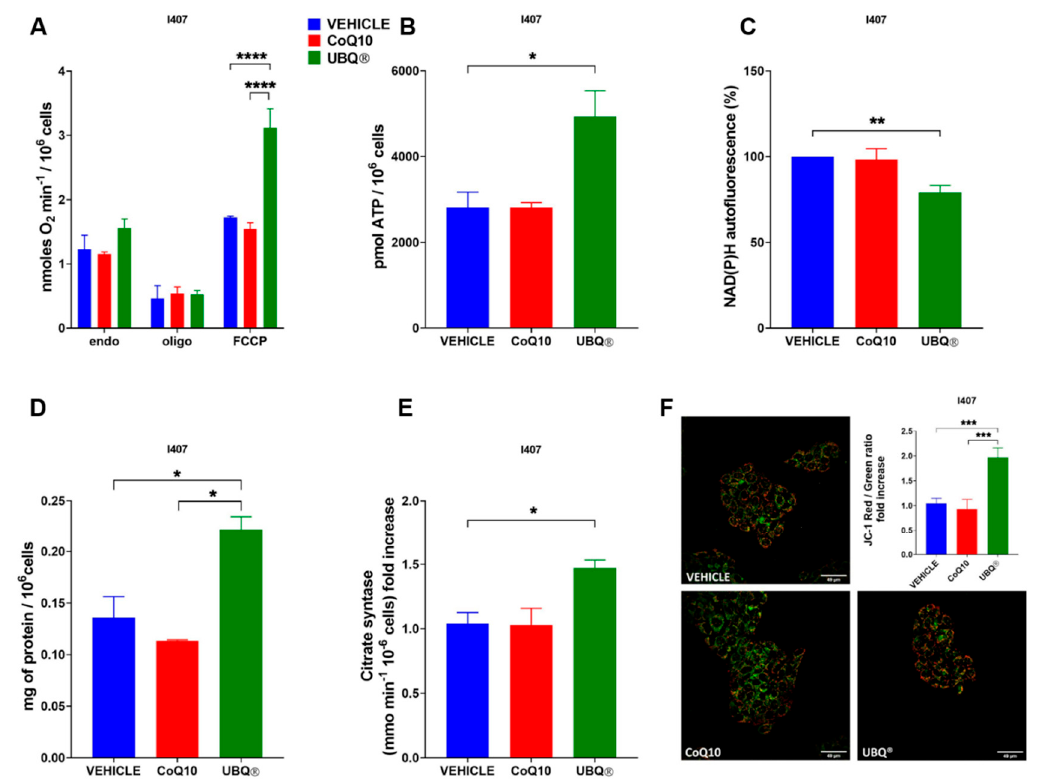
Figure 2. Bioenergetic effects of UBQ treatment in I407 cells. Cells were incubated with 100 nM CoQ10 phytosome (UBQ), native CoQ10 (Q10) and phytosome (vehicle) as described in the materials and methods section. ( A ) Mitochondrial Oxygen consumption rate in intact cells (endogenous respiration, endo), in the presence of 1 µ M oligomycin A (oligo) and 0.25–1 µ M carbonyl cyanide 4-(trifluoromethoxy) phenylhydrazone (FCCP). Data are expressed as nanomoles of oxygen per minute and normalized to the cell number ( n = 3). ( B ) Total cellular ATP quantification in cell lysate ( n = 3). ( C ) NAD(P)H autofluorescence determination in intact cells. Data were normalized to cell number and expressed as a percentage of vehicle-treated sample fluorescence signal; ( n = 3). ( D ) Cellular protein content determination ( n = 3). ( E ) Citrate synthase activity determination normalized to cell number. Data are shown as fold increase over vehicle-treated sample; ( n = 3). ( F ) Representative micrographs of intact cells stained with the fluorescent dye JC-1. Quantitative analysis of Red/Green fluorescence ratio was performed using ImageJ software. For each condition, at least two randomly chosen fields were analyzed. Data are presented as Red/Green fluorescence ratio fold increase over the vehicle-treated sample; ( n = 5). For all panels, data are presented as the mean ± s.e.m, * p ≤ 0.05; ** p ≤ 0.01; *** p ≤ 0.001; **** p ≤ 0.0001. Statistical analysis was performed using one-way ANOVA followed by Tukey’s honest significant difference test.